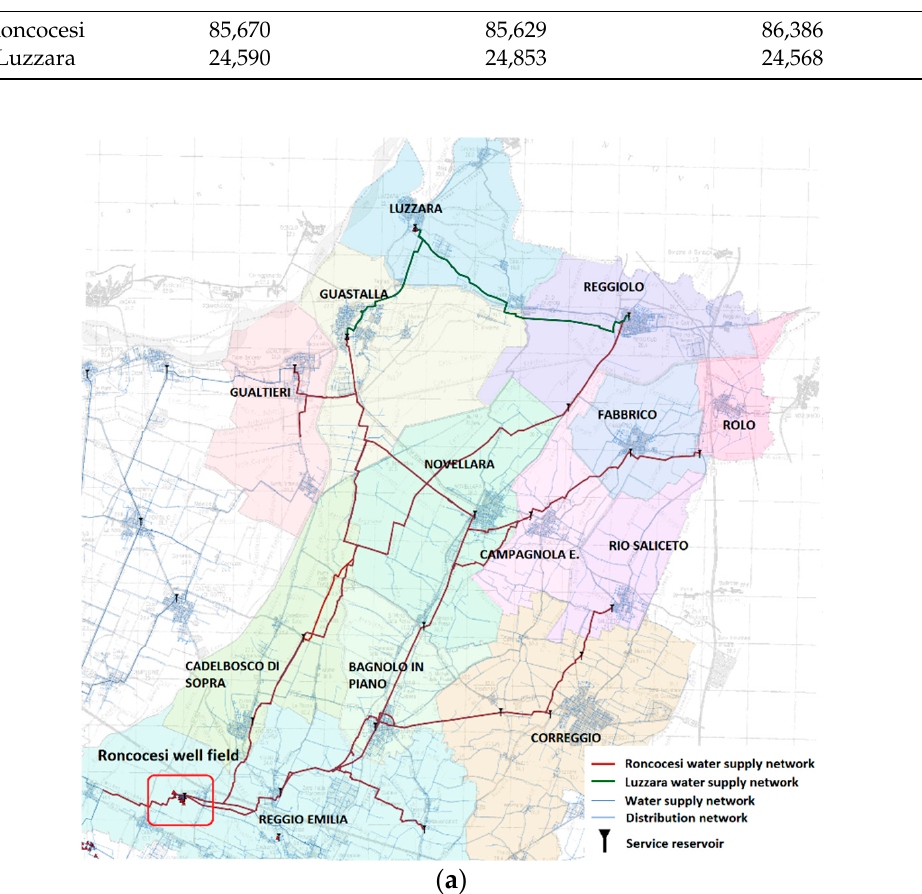
Table 1. Inhabitants served by Roncocesi and Luzzara water networks from 2012 to 2014. WSN Served Inhabitants 2012 Served Inhabitants 2013 Served Inhabitants 2014 Roncocesi 85,670 85,629 86,386 Luzzara 24,590 24,853